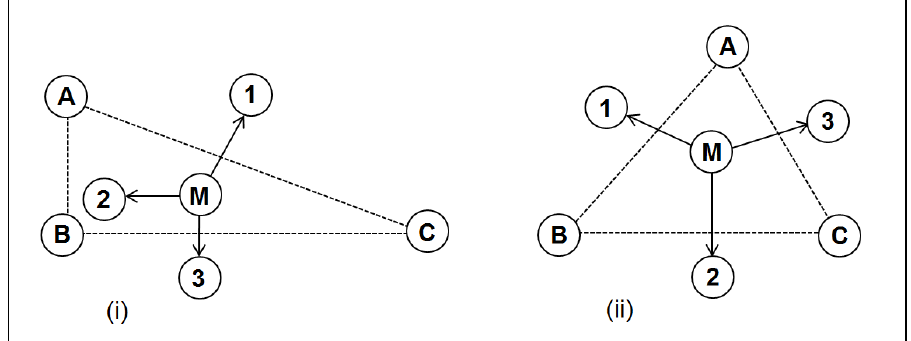
Figure 2. Two instances of inappropriate triangles.